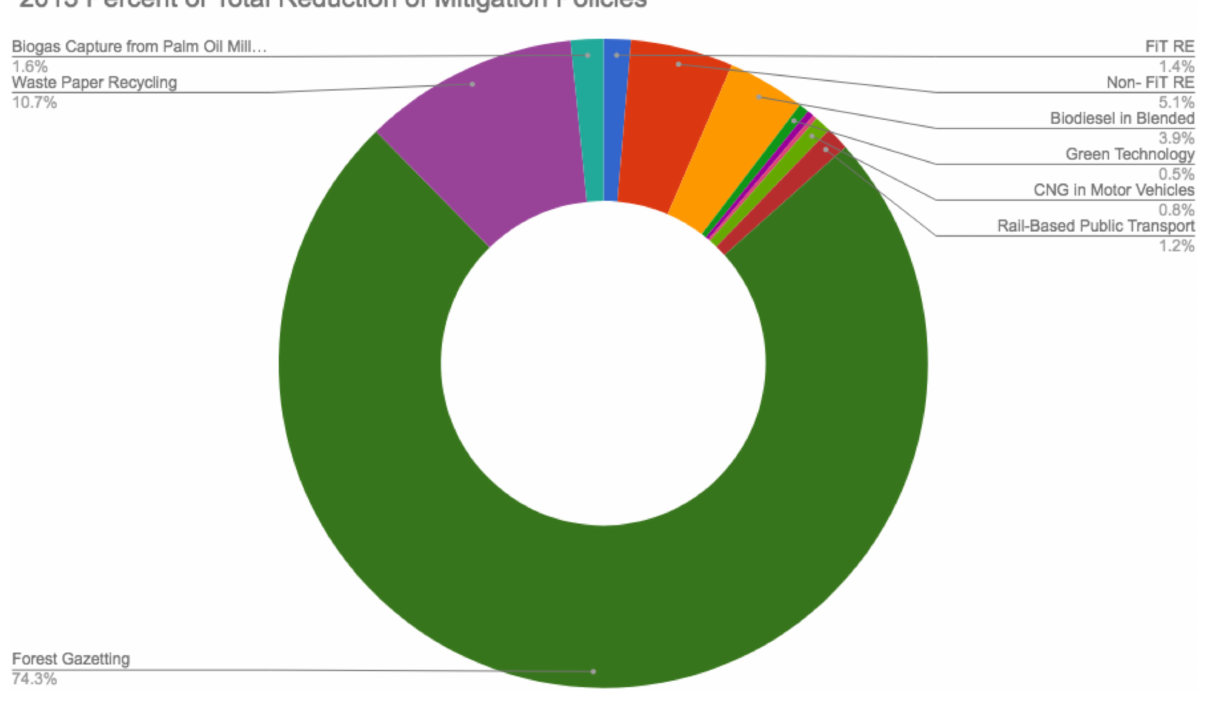
FIGURE 1 | Percentage of Emission Reduction by Mitigation Tools (2013). Data from the first Malaysian Biennial Update Report (Ministry of Natural Resources and Environment, 2015).